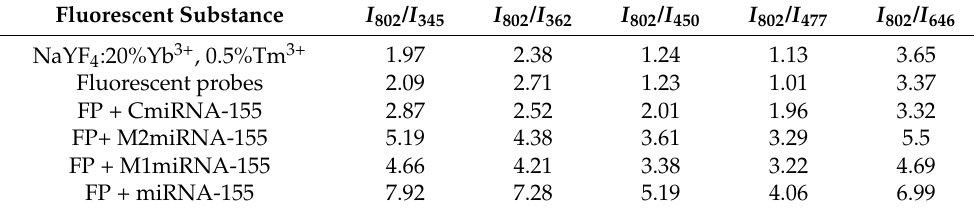
Table 2. The ratio of fluorescence peaks at 802 nm and 450 nm.